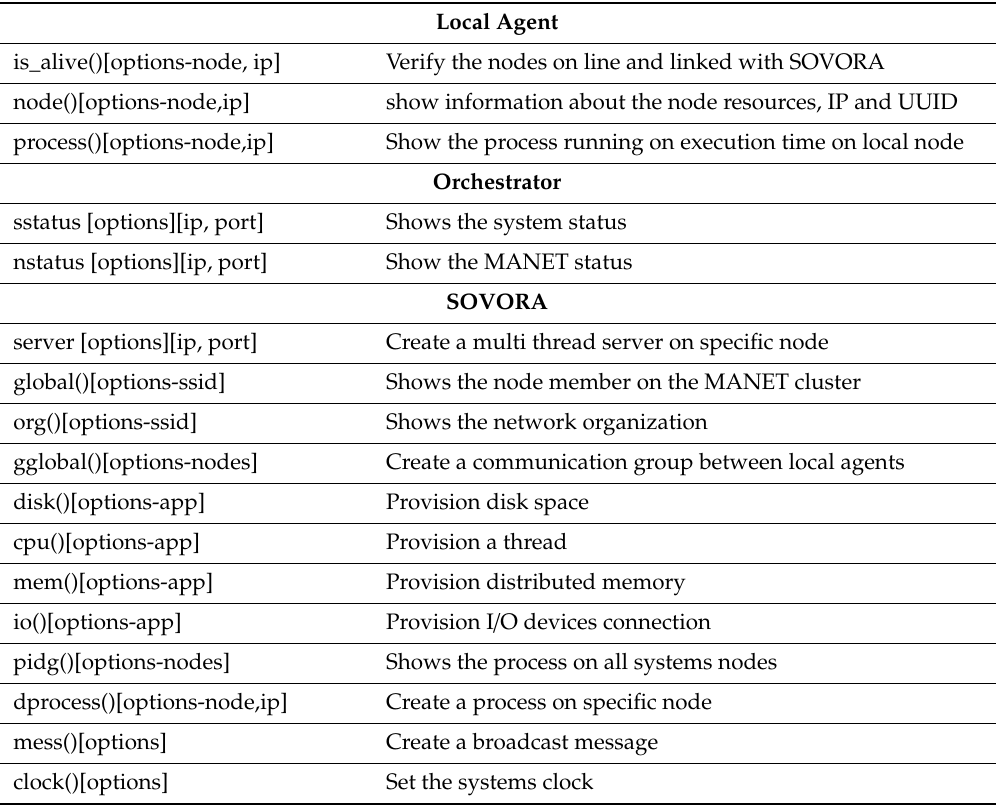
Table 1. S.O.V.O.R.A. terminal commands. Local